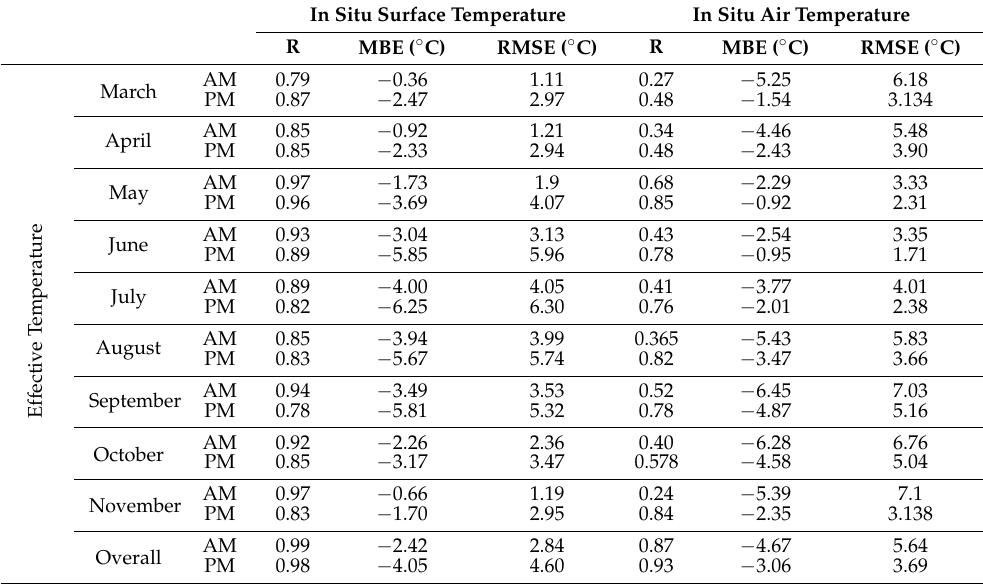
Table 1. Comparison between the modeled surface temperature used for SM retrievals and the measured surface and air temperature. In Situ Surface